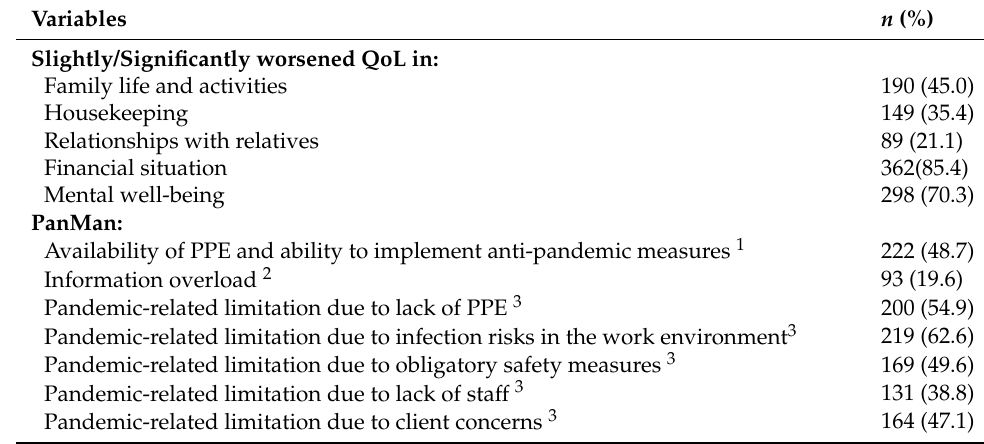
Table 2. Impact on quality of life (QoL) and exposure to effects of the pandemic management (PanMan) (Slovakia 2020; n = 500